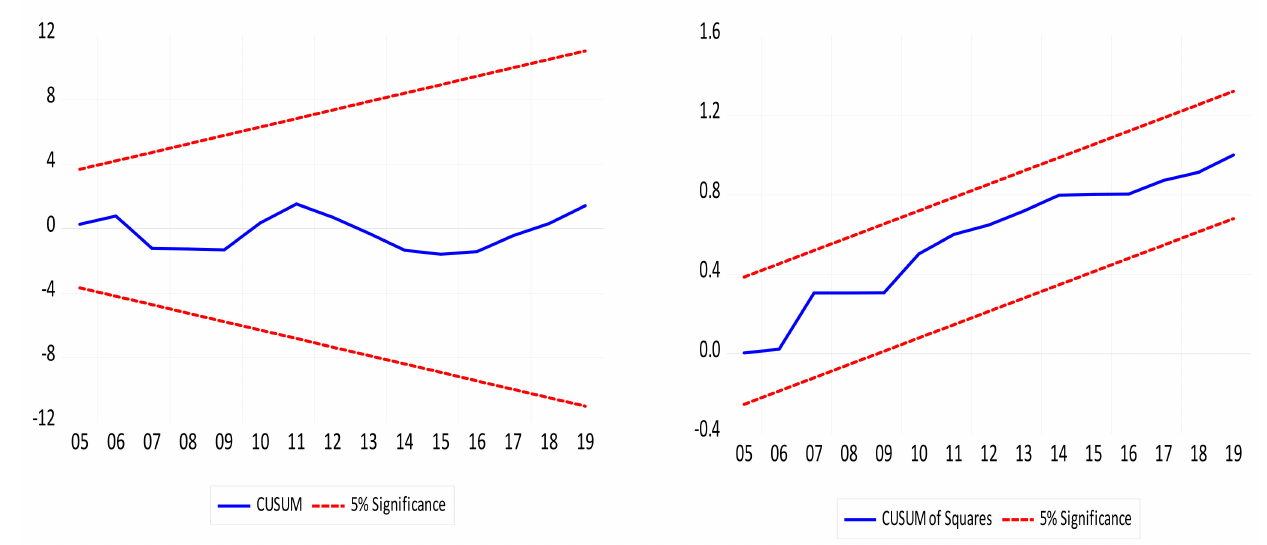
Figure 2. Stability test. ( a ): CUSUM, ( b ): CUSUM of